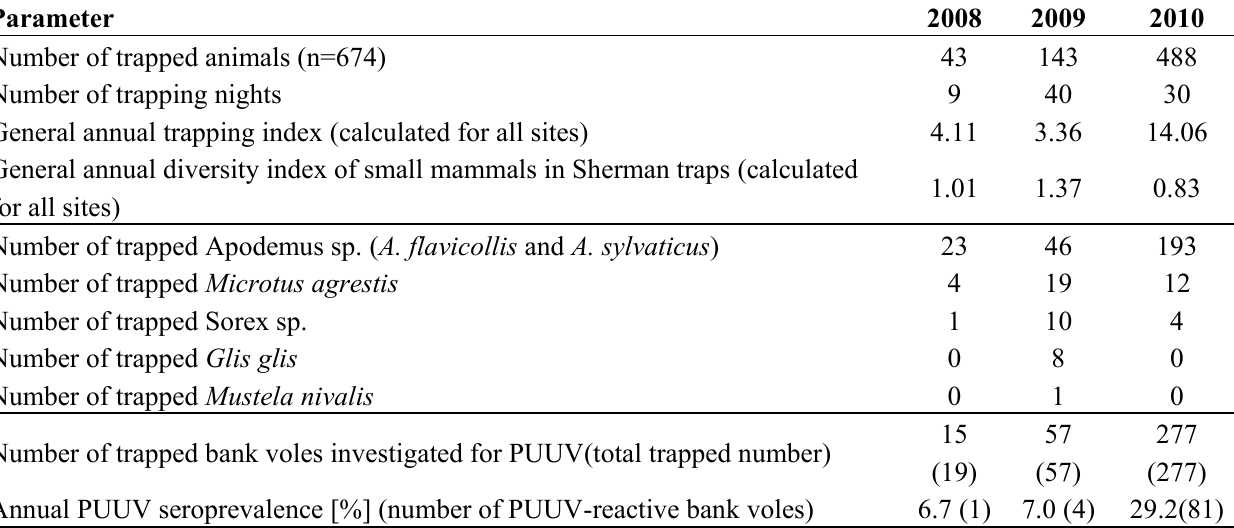
Table 1. Abundance of animals, trapping index, diversity index and PUUV seroprevalence in bank voles per